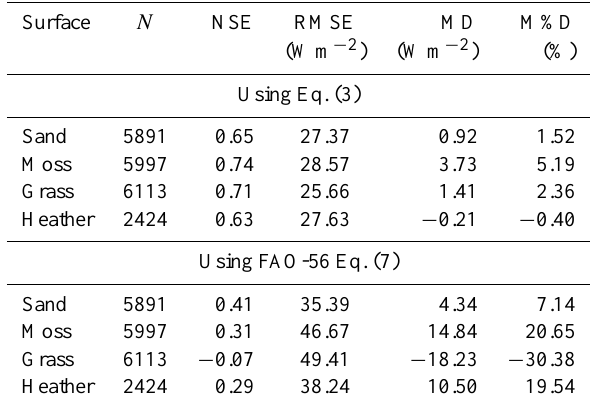
Table 3. Model performance of R nl simulations for hourly time